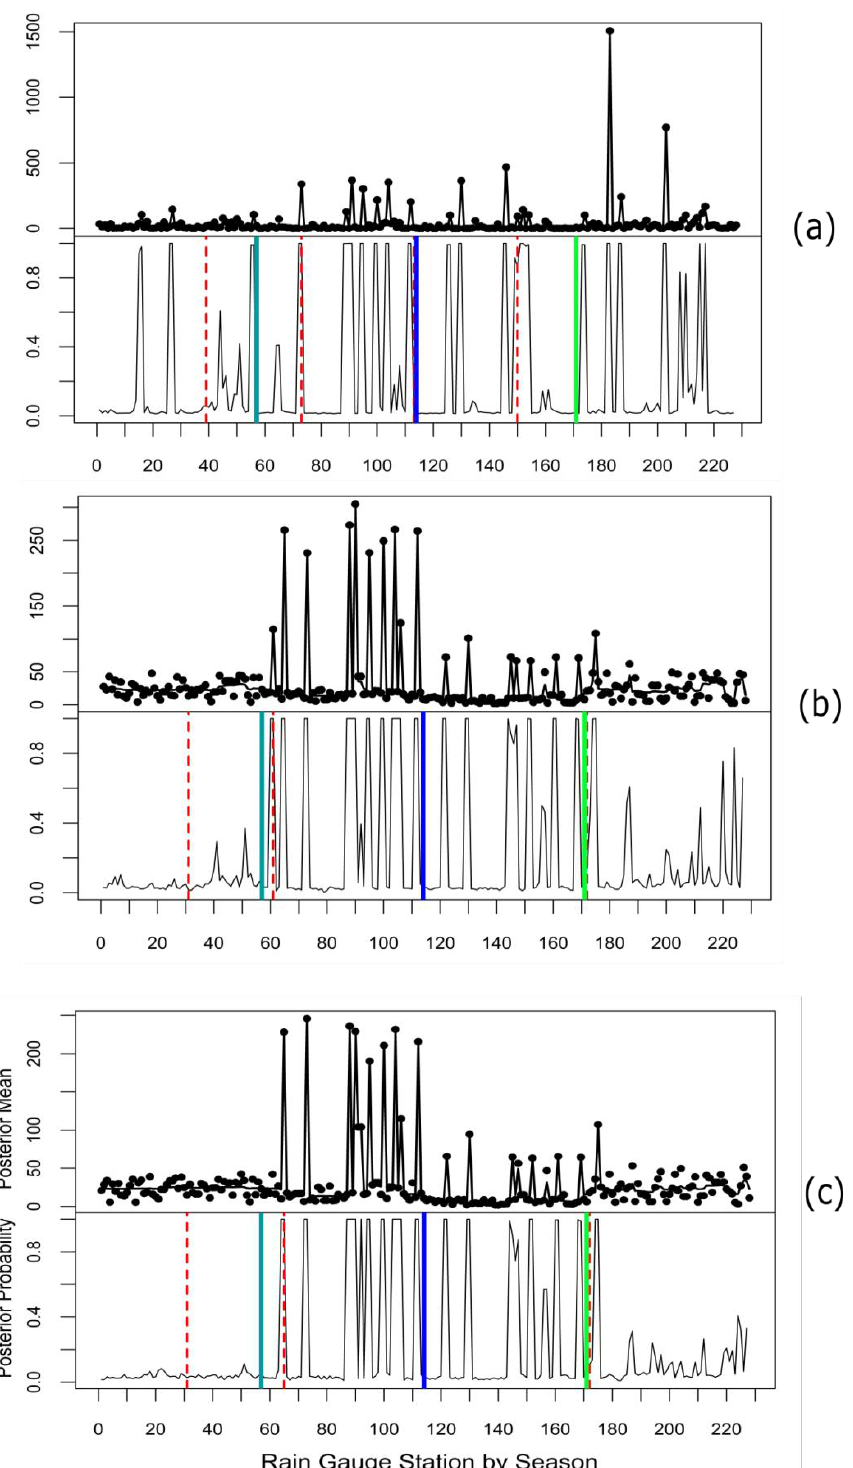
Figure 12. Bayesian change point (bcp) and nonparametric approach for multiple change point analysis (ecp) results for 2018 (seasonal accumulation) for ( a ) OBSERVED, ( b ) TRMM, and ( c ) GPM. The solid lines show the original seasonal partitioning season (the teal color indicates when DJF (winter) ends and spring (MAM) begins, the blue color when spring ends and summer (JJA) begins, and green when summer ends and autumn (SON) begins). The dash red lines show the change points derived using both bcp and ecp. The X -axis indicates the total number of rain-gauge stations (57) used, meaning each partition (solid line and season) has 57 stations.